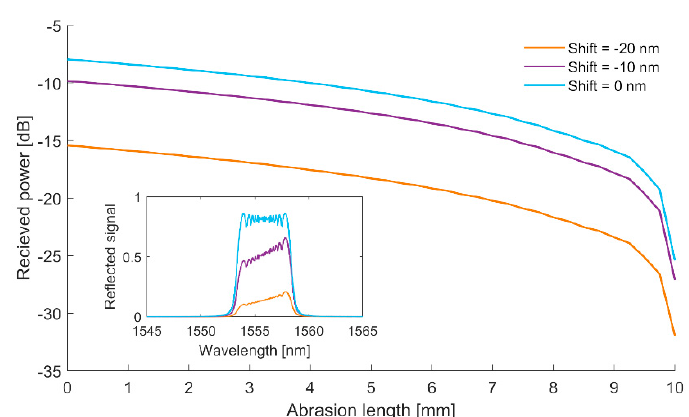
Figure 2. Received power versus the length of the grating for several mutual positions of the center of the Bragg grating reflection and SLED generation. Initial Bragg grating length, of which the spectral response is presented in the inset graph, is assumed to be 10 mm.